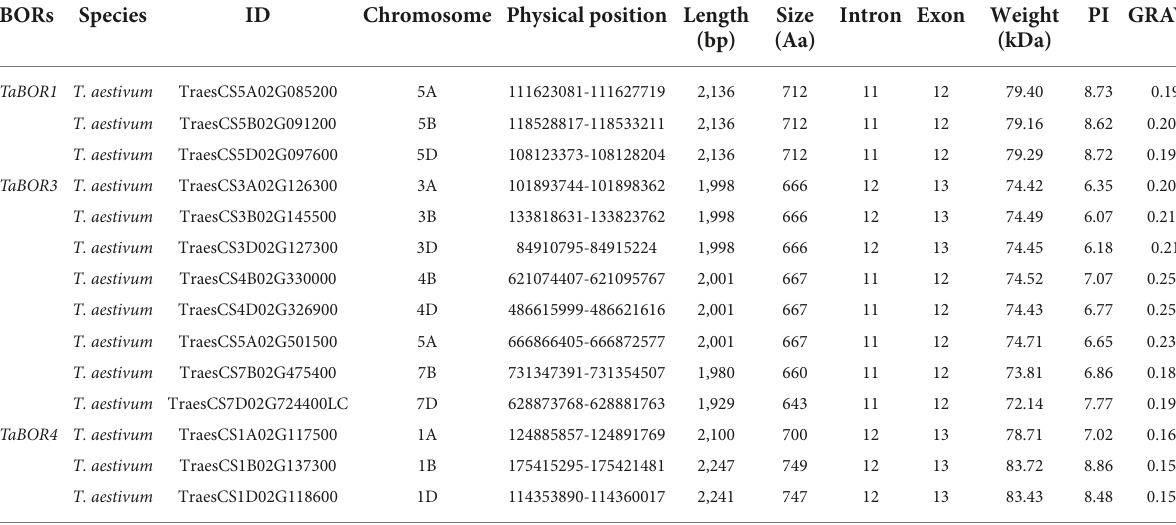
TABLE 1 Gene sequence characteristics and protein physicochemical properties of TaBORs